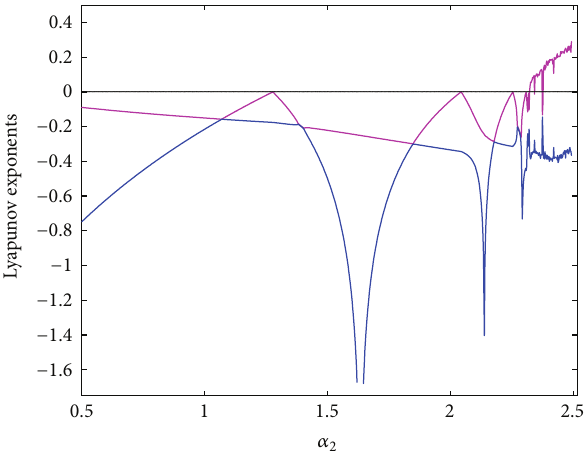
Figure 4: For 𝛼 1 = 1.13 and 𝛼 2 = 1.46 , the wave plots of system (6) with the change of time.